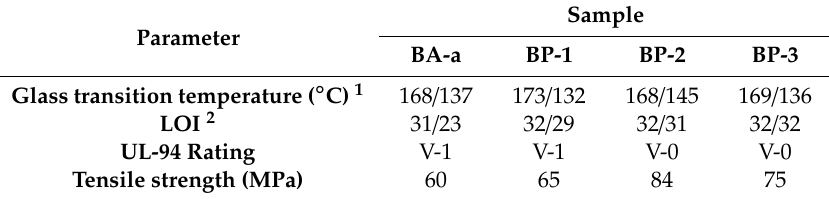
Table 5. Thermal and mechanical properties and flammability of polybenzoxazines. Parameter